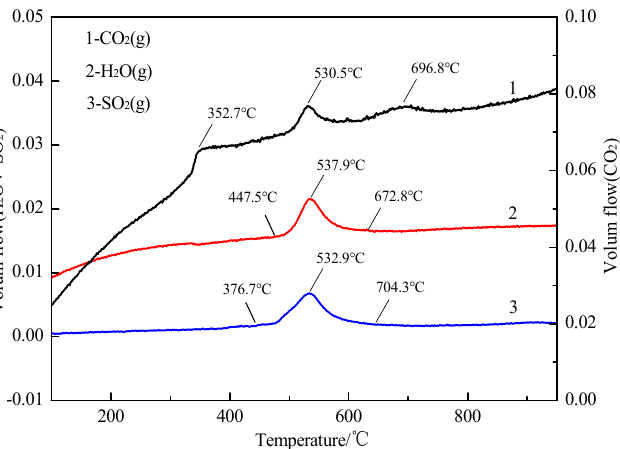
Figure 5. Relationship between the temperature and flow of three kinds of gas with a heating rate of 15 °C/min.